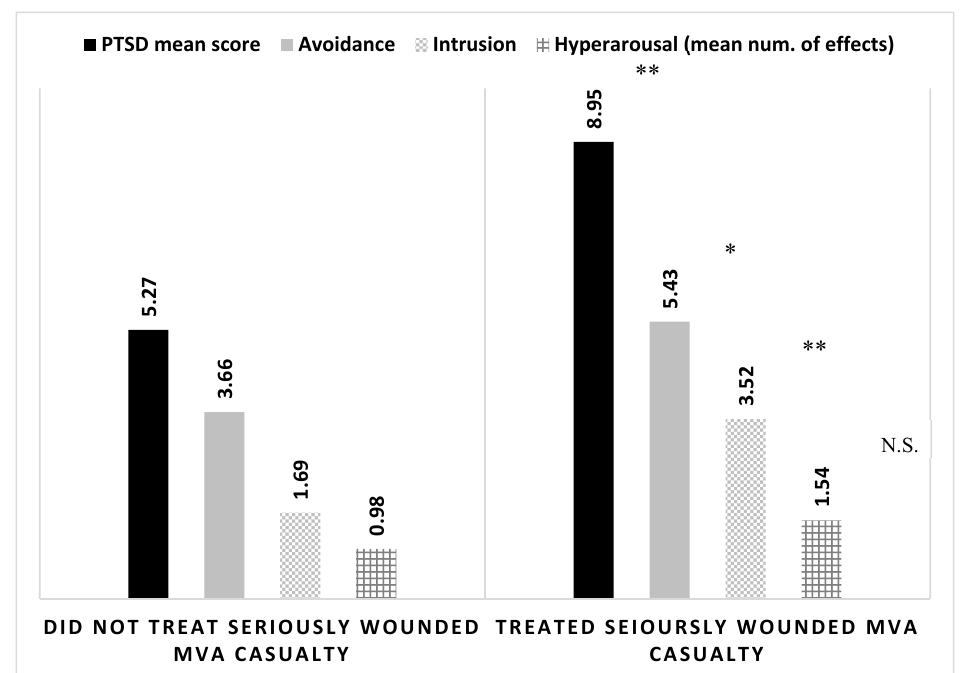
Figure 2. Mean levels of PTSD mean score and sub-components according to experience with treating a seriously wounded MVA casualty by MDA youth volunteers ( N = 236). Statistical differences established with Mann–Whitney U-test. * p -value < 0.05 ** p -value < 0.01 MVA = Motor Vehicle